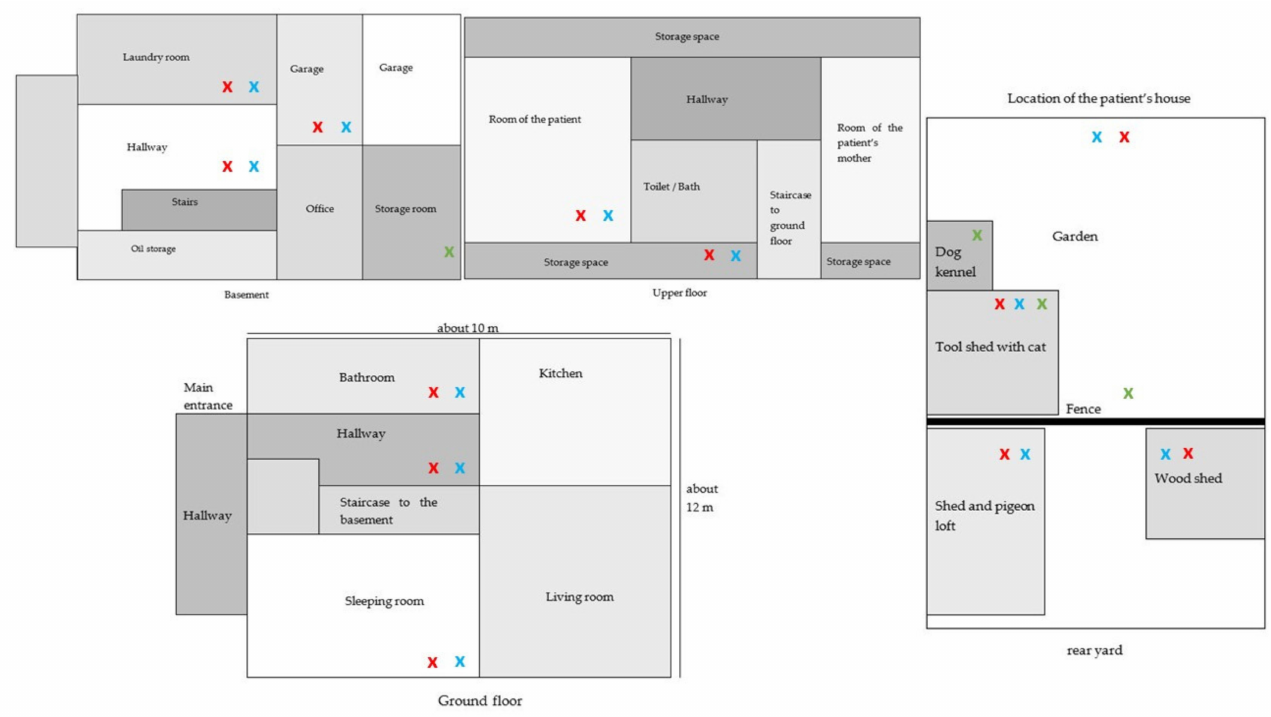
Figure 1. Sketch of the patient’s house and its surroundings. Sites of measurement of the weather conditions during the assessment are marked with blue “x” symbols, sites of airborne pathogen collections with red “x” symbols and points of smears or similar sample taking with green “x”